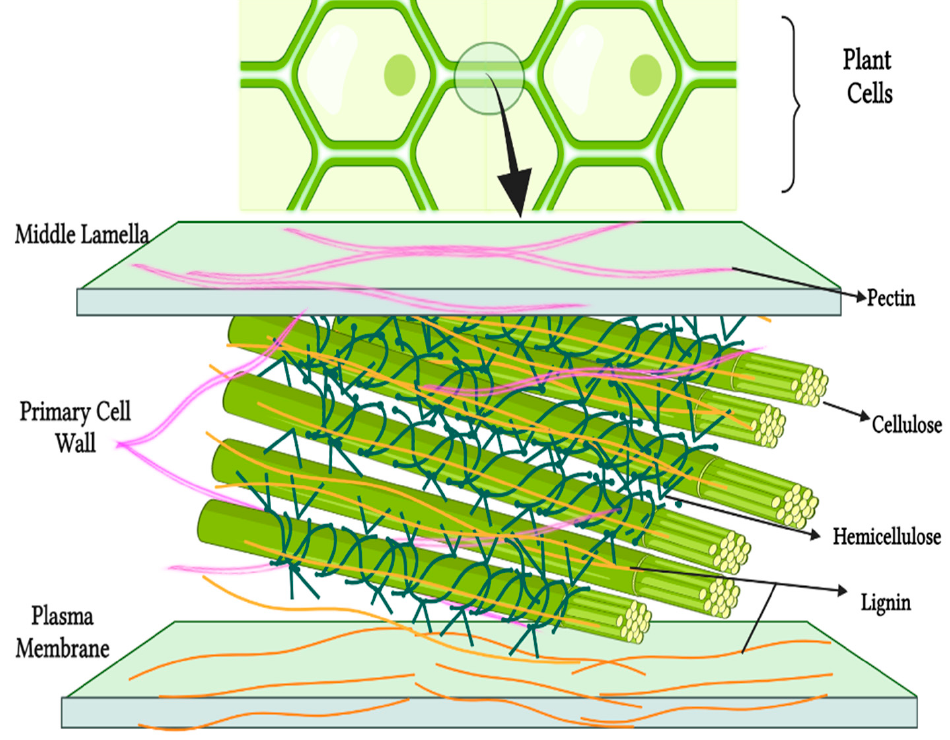
Figure 1. Fiber localization in plants. Created with BioRender.com.